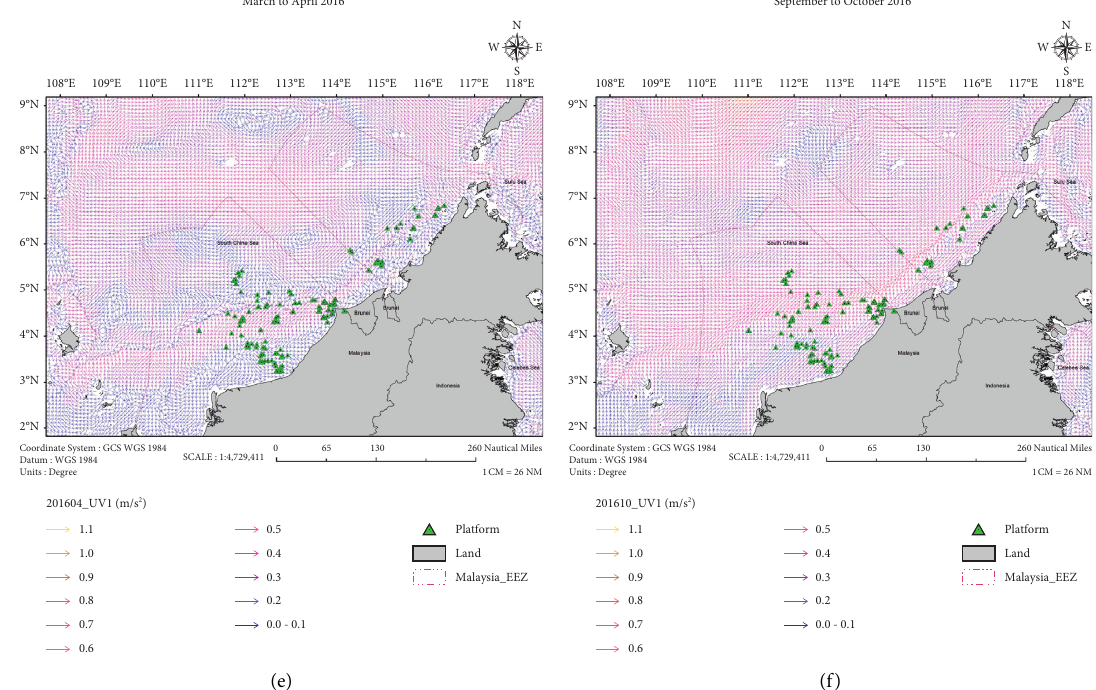
Figure 7: Surface current in Malaysia during March to April and September to October 2016. (a, b) North of Peninsular Malaysia. (c, d) South of Peninsular Malaysia. (e, f) Sabah and Sarawak.